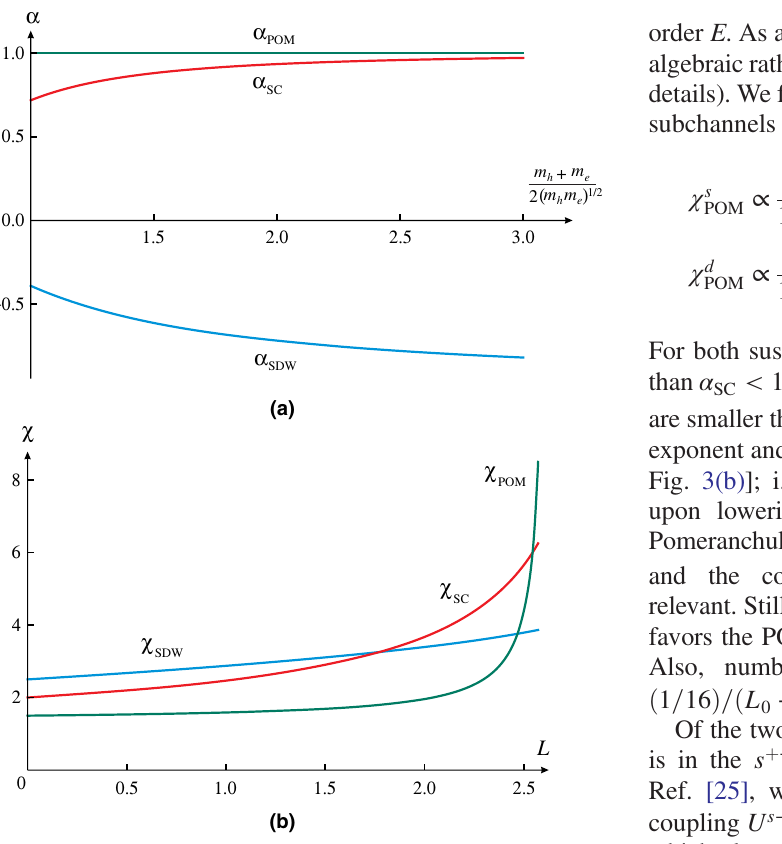
FIG. 3. RG flow of the susceptibilities. (a) The exponents for ∝ 1 = ð L − L Þ α the susceptibilities χ in SDW, s þ − SC, and POM 0 p ffiffiffiffiffiffiffiffiffiffiffiffi i i Þ . The largest þ m Þ = ð 2 m m channels as functions of C ¼ ð m e h e h ¼ 1 is in the Pomeranchuk channel. The ex- exponent α POM < 0 , which implies that within RG χ ponent α does not SDW SDW diverge. (b) The schematic behavior of susceptibilities in SDW, s þ − SC, and POM channels. We use the couplings along the fixed trajectories as inputs for the RG equations for the suscep- tibilities. The Pomeranchuk susceptibility actually diverges at L ¼ L < L 0 . As a result, the leading instability upon lowering P the temperature is towards d -wave orbital ordering. s þ − super- conductivity develops at a smaller T , and SDW instability does ¼ log W=E not develop. This holds when L 0 is smaller than L , F F i.e., if the instability develops at an energy or temperature larger < L 0 , the RG flow runs up to L ¼ L than E . If L , and at F F F larger L , SDW and SC channels decouple and develop indepen- dent of each other, while the Pomeranchuk channel gets frozen. In this situation, the system first develops either SDW or SC order, depending on the interplay between L and L 0 and the degree of F